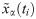
Sample of time-series.Time-series x˜α(ti) for the top product “D2” and for the five kinds of time-series, namely, P, Q, Visit, TVAd, and search are shown from top to bottom.